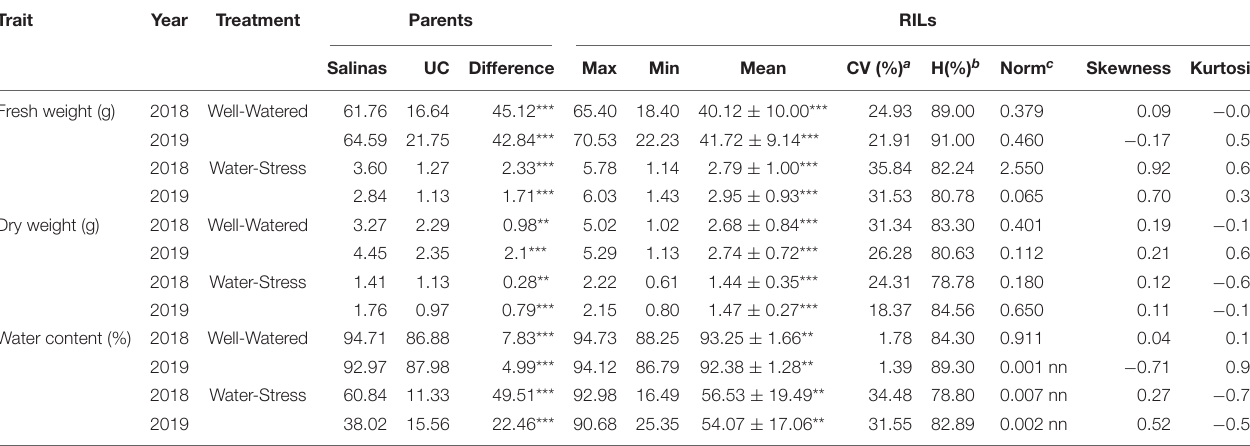
TABLE 1 | Phenotypic values and broad sense heritability (H) estimate of different water-stress related horticultural traits in a lettuce recombinant inbred line (RIL) population (n = 175) of ‘Salinas’ x US96UC23. Trait